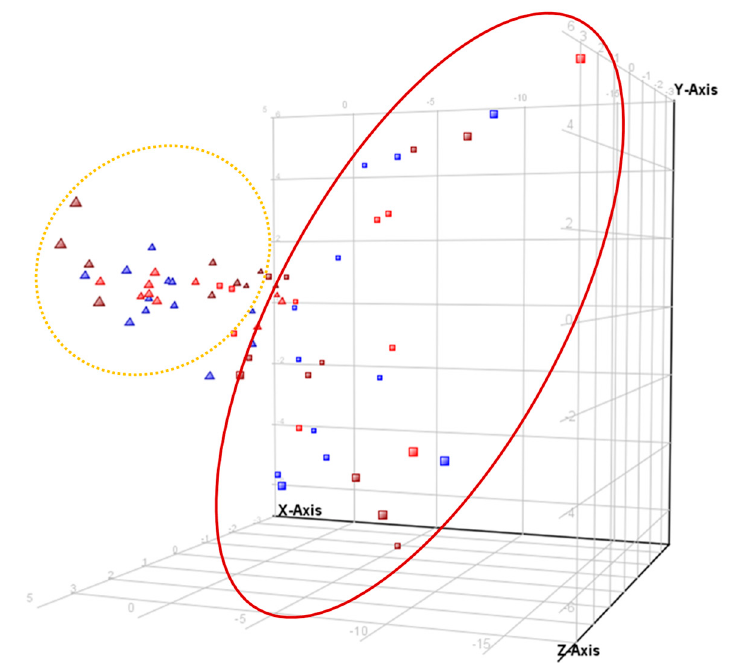
Figure 1. 3D-PCA score plot for serum samples. Red (Group A), blue (Group X), and burgundy (Group A+X) triangles represent samples before intervention (time 0) and red, blue, and burgundy blocks after the 8-months intervention. X-axis represents component 1 (45.96%), Y-axis is component 2 (11.84%) and Z-axis, component 3 (6.78%).